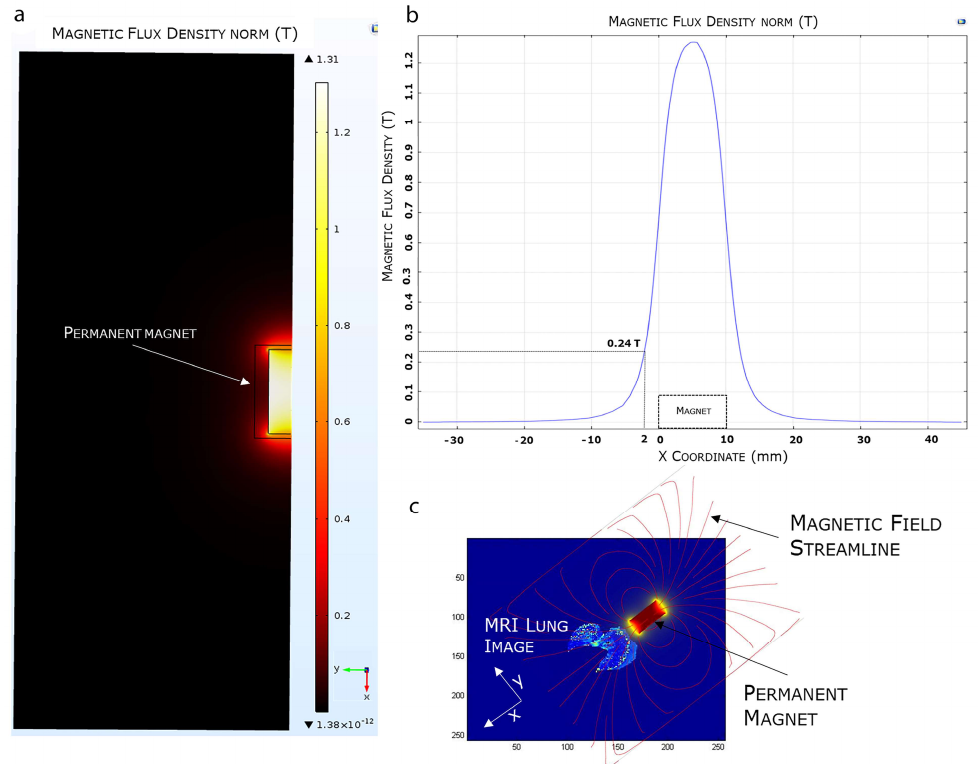
Figure 5. FEA magnetic simulation using COMSOL software. ( a ) 2D representation of the simulated magnetic flux density distribution measured in Tesla (T). ( b ) Magnetic flux density variation. ( c ) Overlapping of the 3D simulated magnetic field on a mice MRI lung model.